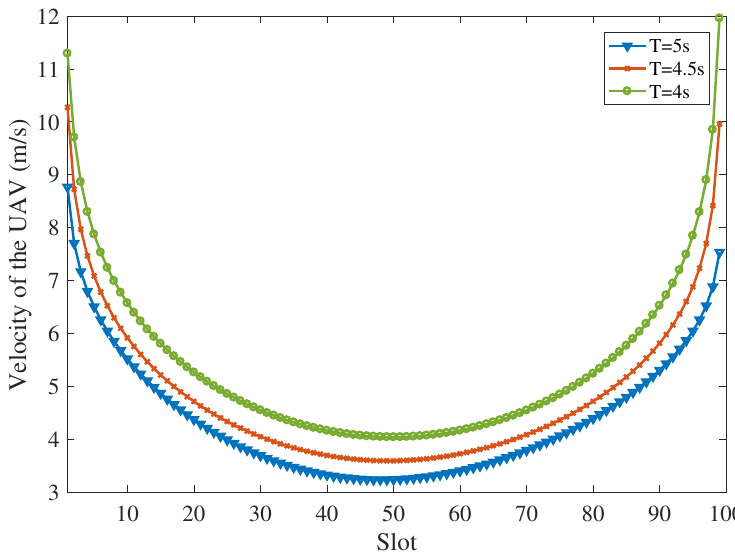
Figure 8. The velocity of the UAV ( I 1 = 4 × 10 7 bits, I 2 = 5 × 10 7 bits, I 3 = 6 × 10 7 bits, I 4 = 7 × 10 7 bits and I 5 = 8 × 10 7 bits).